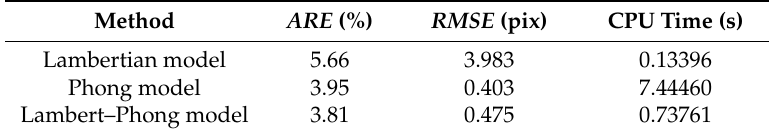
Figure 6. ( a ) Original grayscale composite image (A–B is the cut line for the cross section); ( b ) 3D shape of the composite image and the side cross section contrast diagram using the Lambertian model algorithm (dark blue is the cross section of reconstruction, light blue is the cross section of the real shape); ( c ) 3D shape of the composite image and the side cross section contrast diagram using the Phong hybrid model algorithm; ( d ) highlight detection’s results of the composite image; ( e ) 3D shape of the composite image at the highlight region using the Phong hybrid model algorithm; ( f ) 3D shape of the composite image at the non-highlight region using the Lambertian model algorithm; ( g ) 3D shape of the composite image and the side cross section contrast diagram using the Lambert–Phong model algorithm. Table 1. Comparison of height average relative error ( ARE ), height root mean square error ( RMSE ), and operational speed of the three algorithms for a composite image.